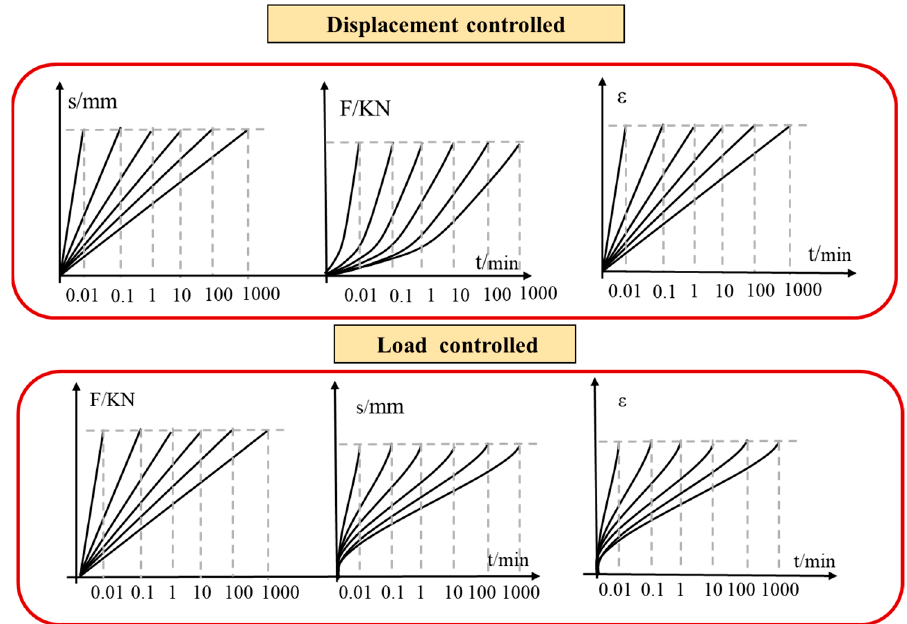
Figure 11. Relationship between strain rate under displacement controlled and load control mode.